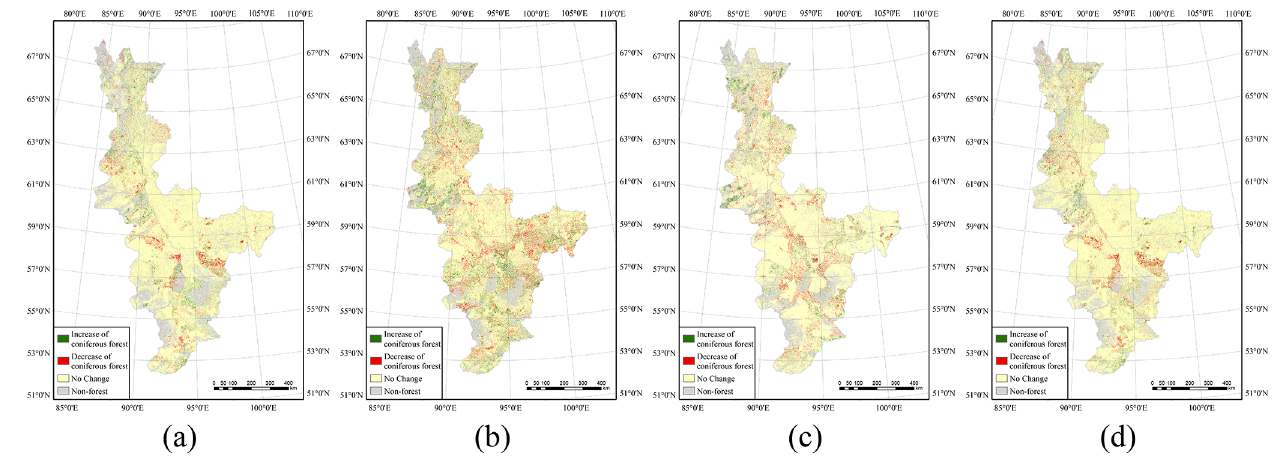
Figure 8. Changes in coniferous forest area for (a) 1985–1995, (b) 1995–2005, (c) 2005–2015 and (d)